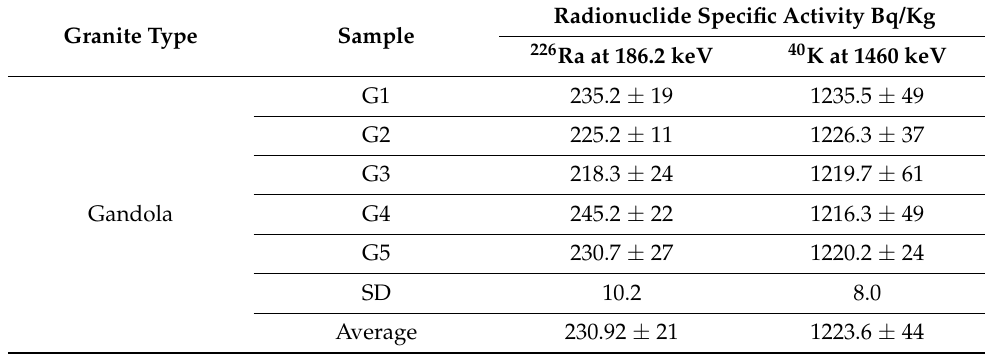
Table 2. Radionuclide specific activity (Bq/Kg) for the different samples by the gamma ray spectrom- eter